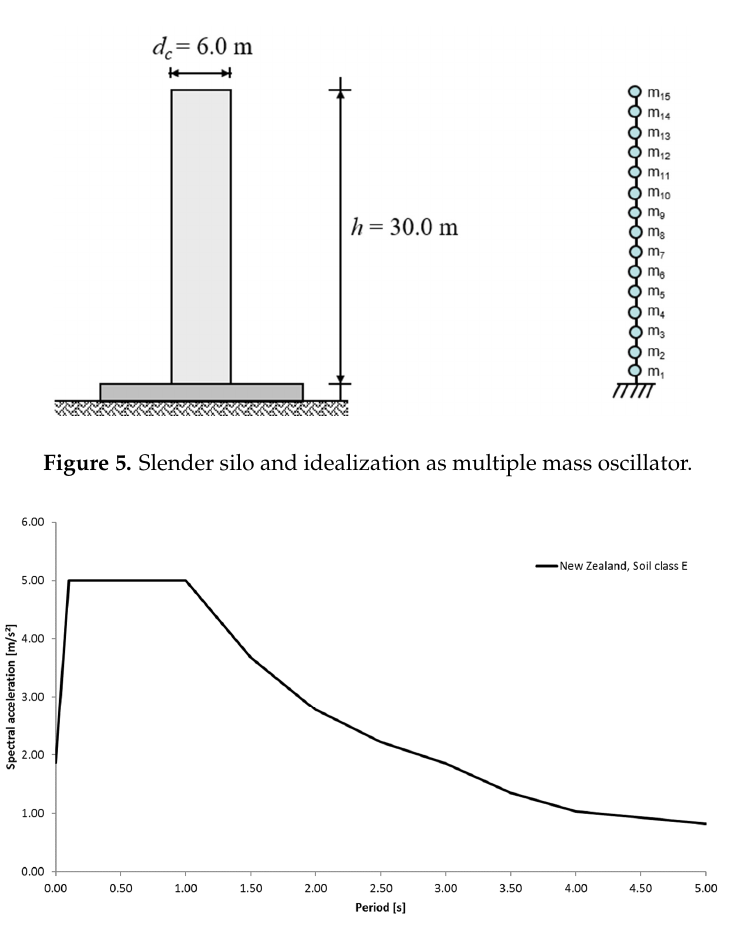
Figure 7. Linear and multimodal acceleration profile. Figure 8. Circumferential and axial stresses as results of the different approaches of the acceleration. 05 1015 20